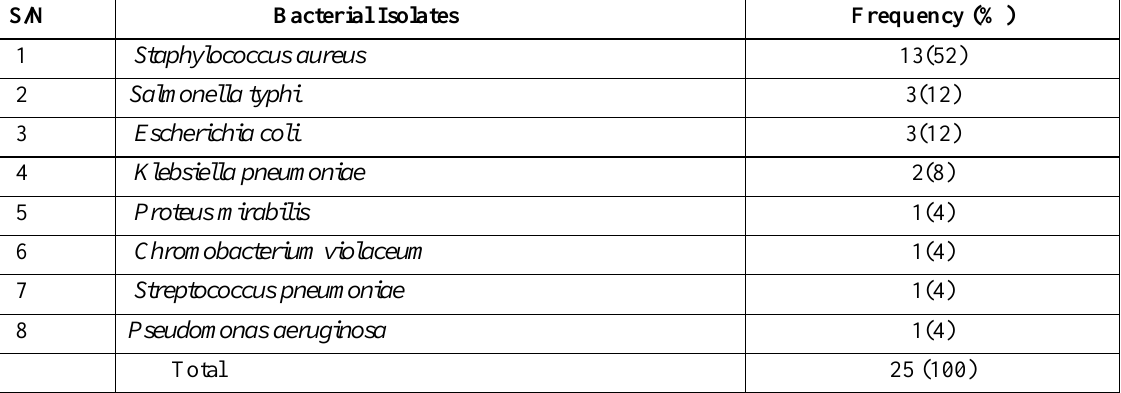
Table 1. Frequency of occurrence of bacterial isolates from HBsAg positive individuals.